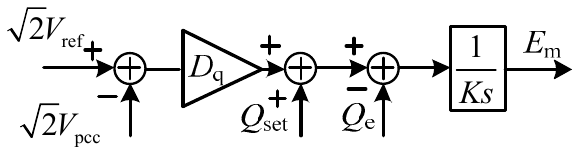
Figure 5. Improved Q – V control loop.